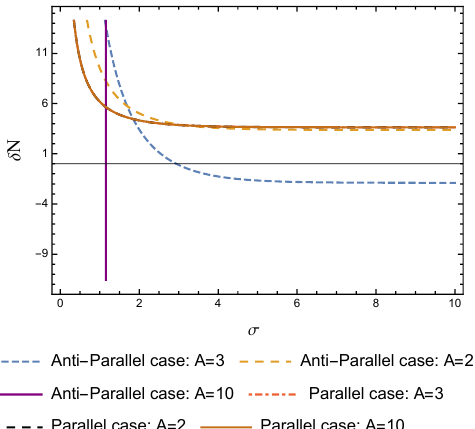
Figure 20 . Parallel and Anti-parallel motions in (1 + 1) dimensions with thermal background: δ N Vs σ plot with ∆ E = 1 , α = 0 . 2 . a B